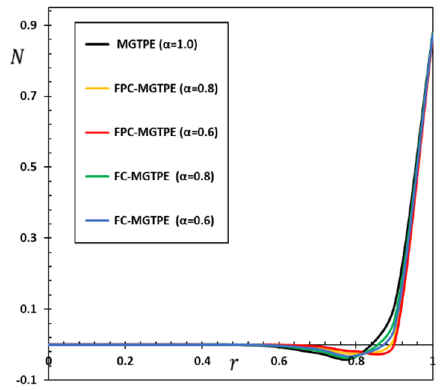
Figure 5. The carrier density 𝑁 for different fractional derivatives.